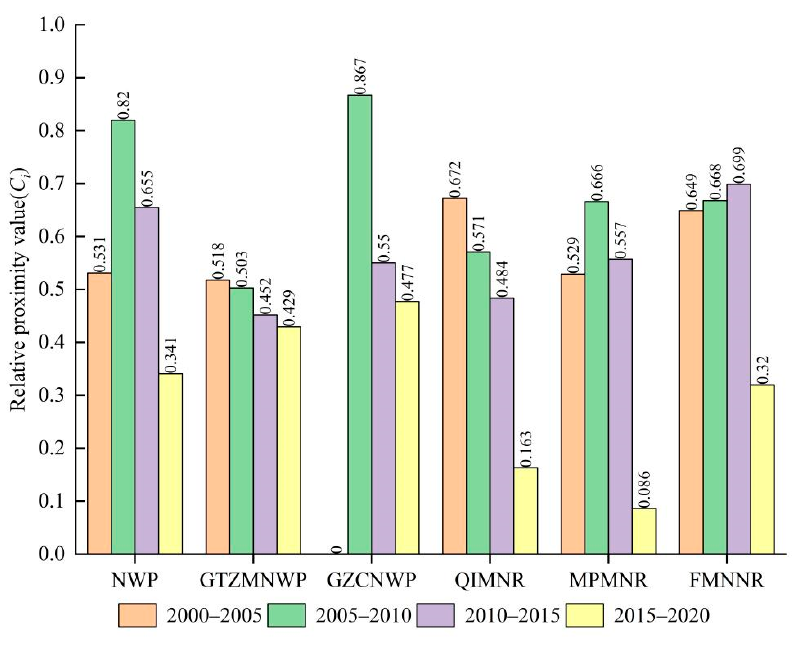
Figure 10. Comprehension scores ( 𝐶 (cid:3036) ) of nature reserves from 2000 to